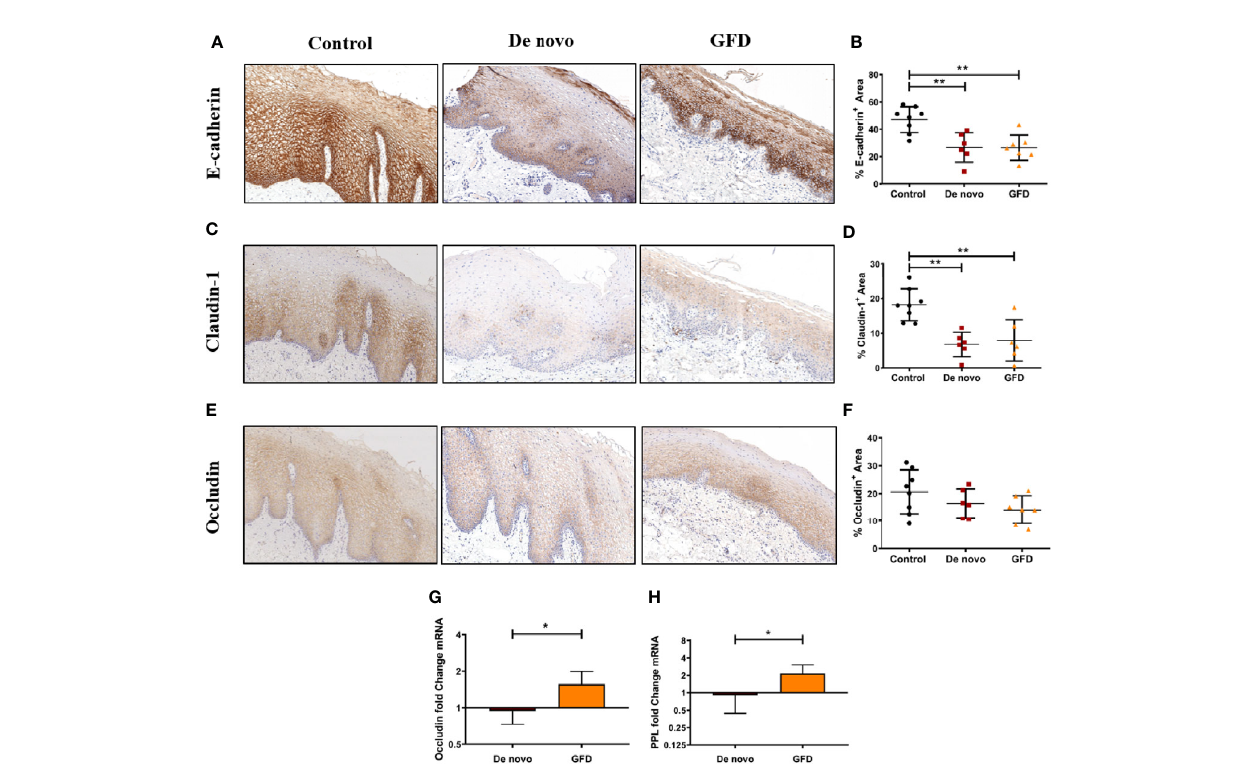
FIGURE 1 | Immunohistochemical staining of FFPE oral mucosal sections and quanti fi cation of protein expression from non-celiac subjects (control) (n = 8) and CD patients de novo diagnosed ( de novo ) (n = 6) and after Gluten Free Diet (GFD) (n = 7) for E-cadherin (A, B) , claudin-1 (C, D) , and occludin (E, F) . Images were captured at 8× magni fi cation. Quanti fi cation is the percentage ‐ stained area (mm 2 ) of the total epithelial area (B, D, F) . Scatter plots show mean ± SD *p < 0.05, **p < 0.01. Fold change expression of occludin (G) and periplakin (PPL) (H) in the oral mucosa for de novo diagnosed (n = 6) and GFD (n = 7) CD patients. Fold change is referred to non-celiac (control) samples using 2 - DD CT method. Data were normalized using two housekeeping genes (GAPDH and b -actin). Bar plots show mean ± SD *p <